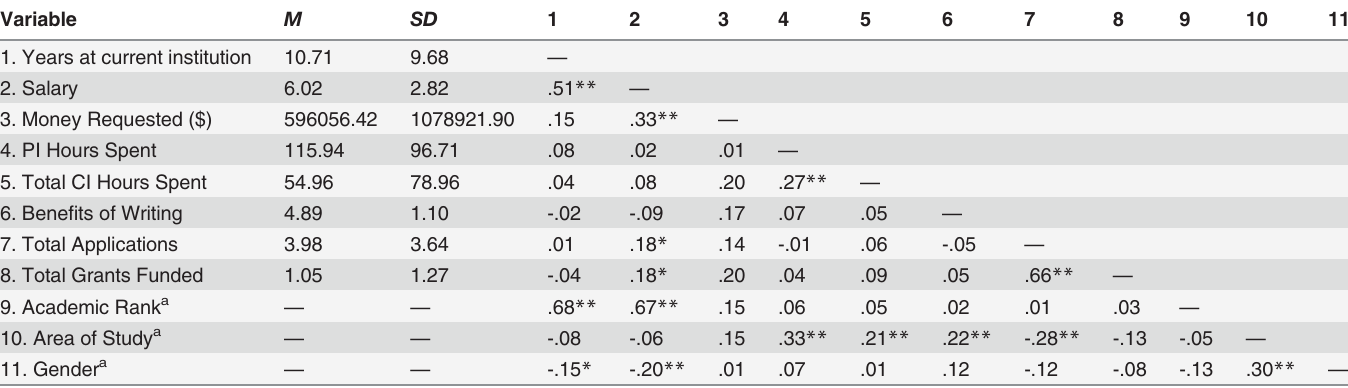
Table 1. Summary of Intercorrelations, Means and Standard Deviations of Study Variables.